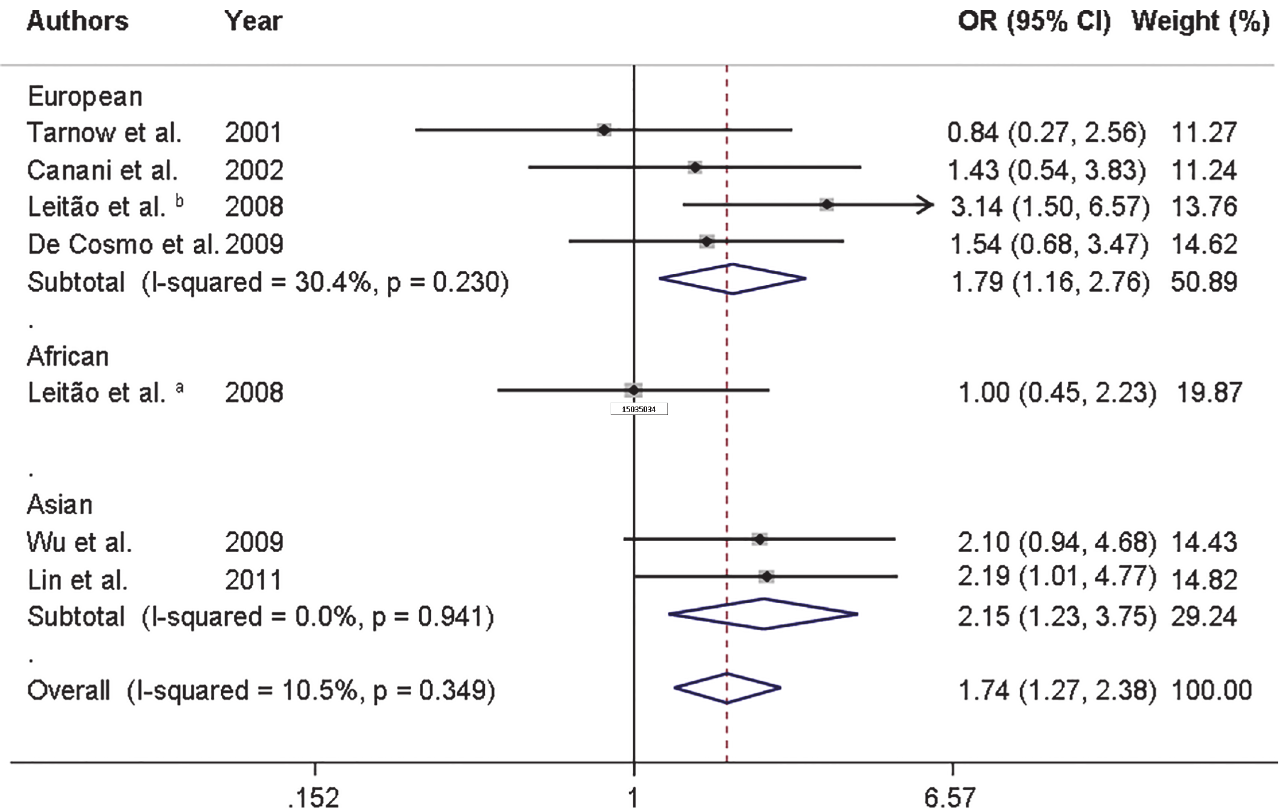
Fig 2. Forest plot showing individual and pooled ORs (95%CI) for the association between the ENPP1 K121Q polymorphism and diabetic kidney disease after stratification by ethnicity, under an additive inheritance model. The area of the squares reflects the study-specific weight. The diamond illustrates the fixed-effect model summary OR (95%